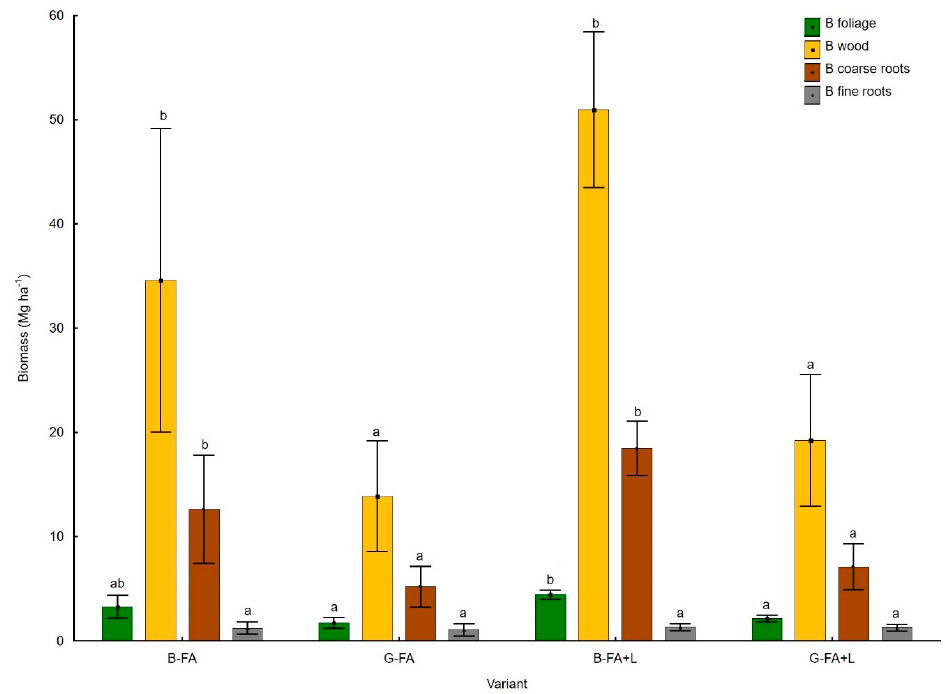
Figure 3. Biomass (B) of two alder species grown on a combustion waste landfill. Table 3. Results of two–way ANOVA of the biomass, carbon and macronutrient stocks in the biomass of alder species on fly ash technosols.